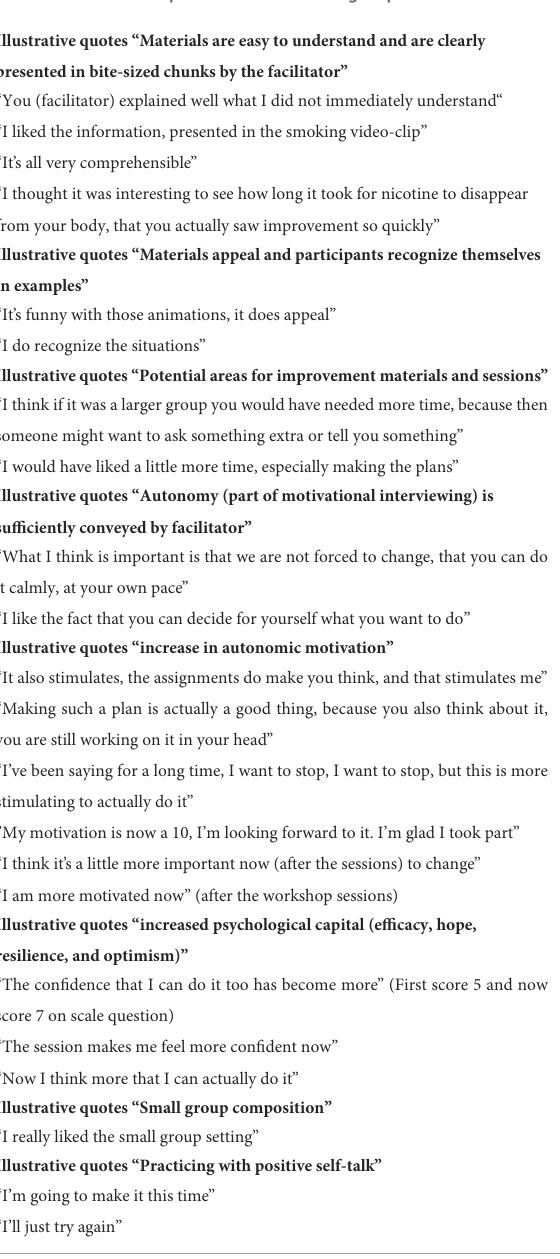
TABLE 2 Illustrative quotes from the focus group